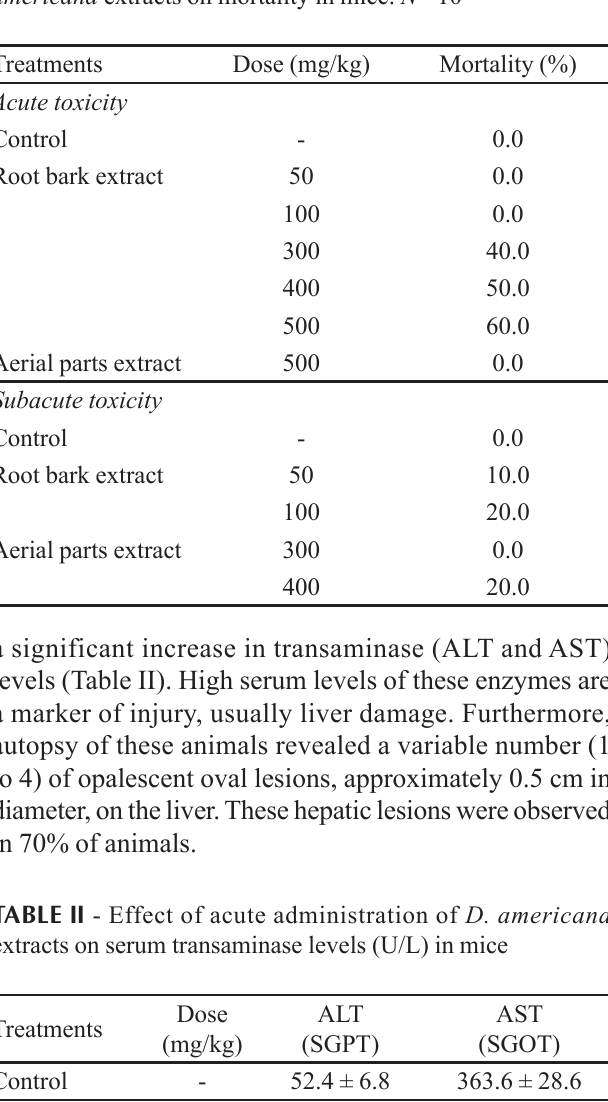
TABLE II - Effect of acute administration of D. americana extracts on serum transaminase levels (U/L) in mice Treatments